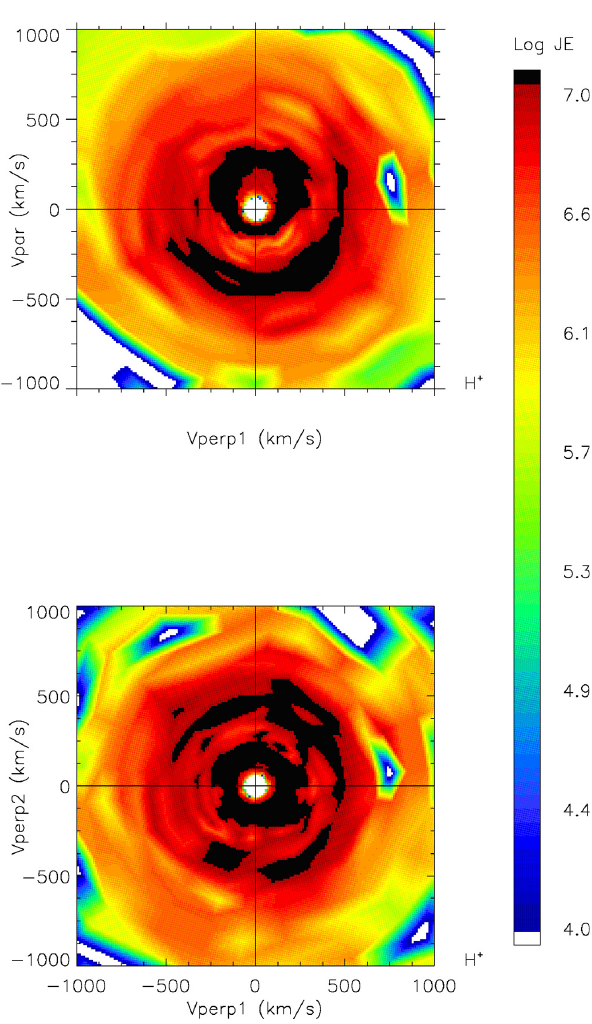
Fig. 2. Cuts of the ion distribution function recorded by CODIF on SC4 at 07:38:33UT in a plane parallel to the magnetic field (top) and perpendicular to the magnetic field (bottom).